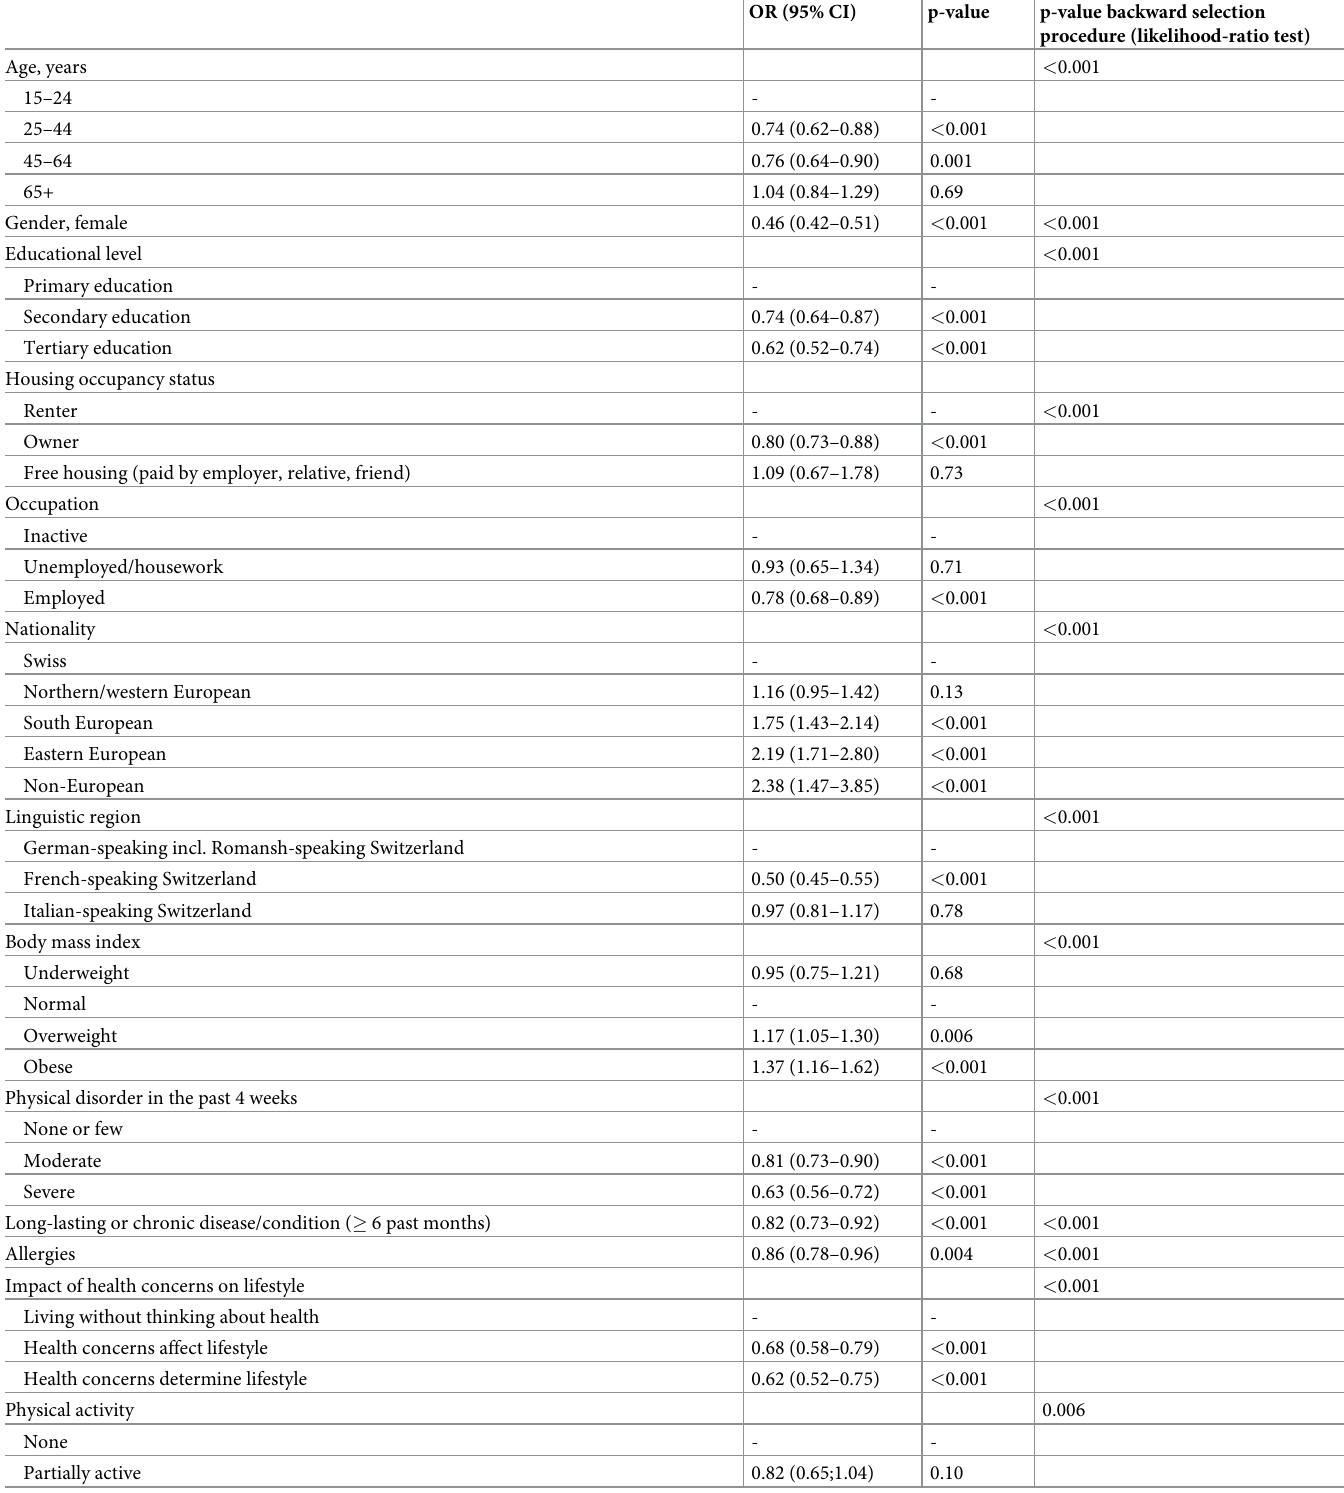
Table 8. Determinants of CM non-user using multivariate logistic